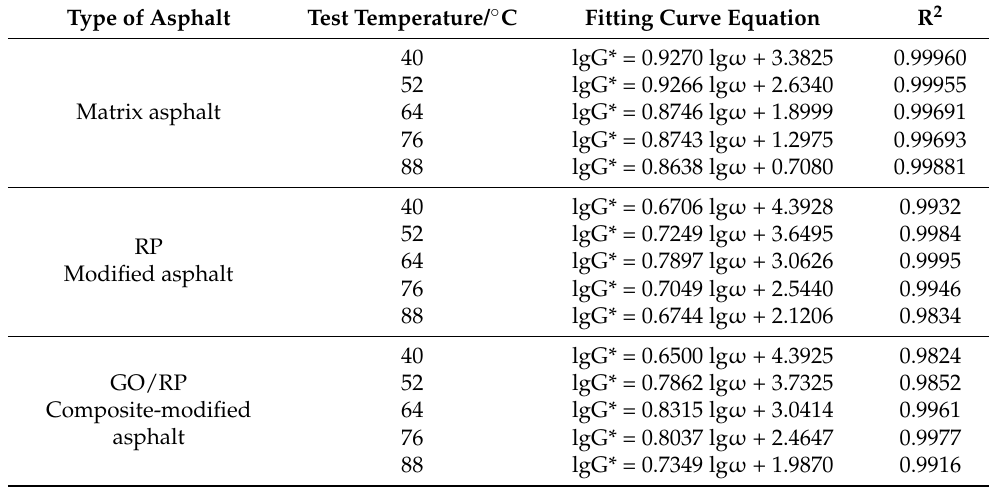
Table 4. Summary of various asphalt double logarithmic fitting curves.